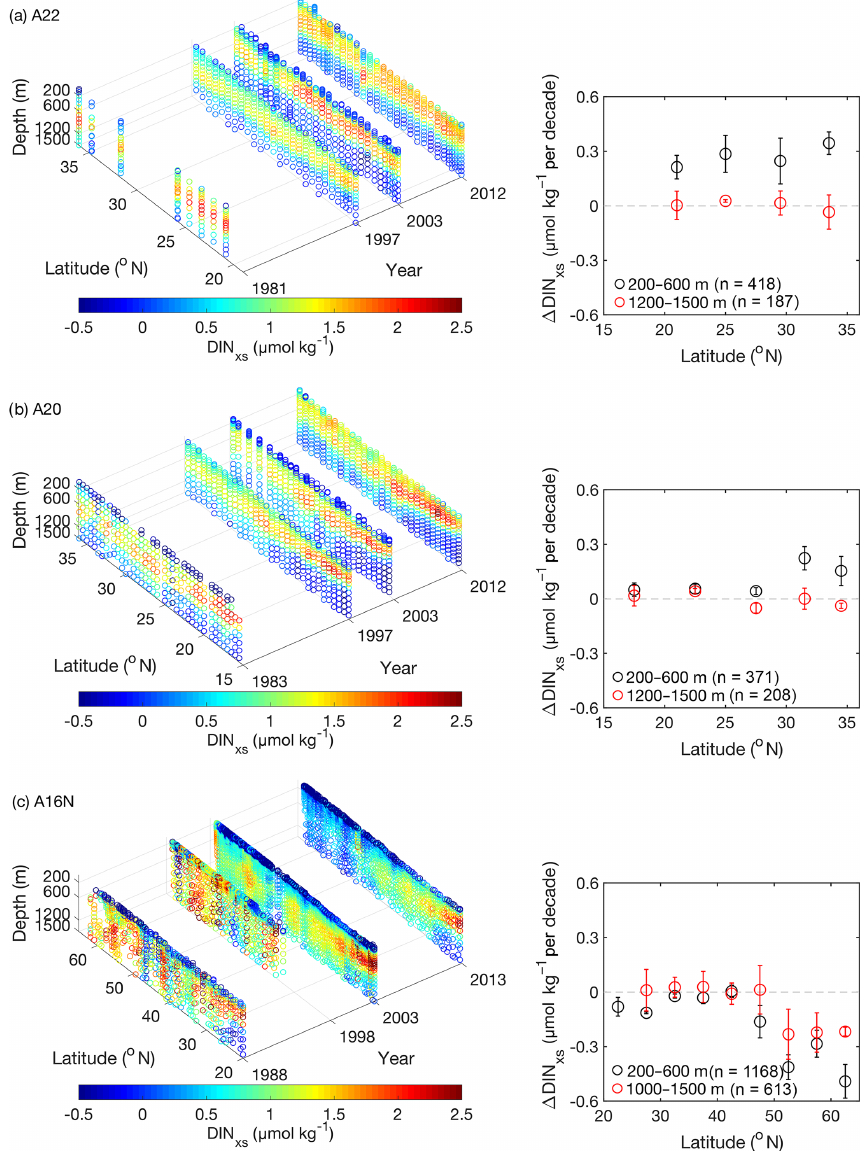
Figure 2. The vertical distributions of DIN xs in the upper 1500m for different cruises along three meridional transects are shown in (a) A22, (b) A20, and (c) A16N, respectively. The insets in (a) – (c) show the average rates (with 95% confidence limits) of (cid:49) DIN xs at 200–600m and 1200–1500m averaged for each 3–8 ◦ latitude interval between GO-SHIP (2010s) and WOCE (late 1980s to 1990s) time periods along each transect (see Table S1). Data from three cruises between the GO-SHIP and WOCE time periods were used to calculate the (cid:49) DIN xs along each transect (numbers in the insets indicate the number of data points for the (cid:49) DIN xs estimates at depth ranges of 200–600 and 1200–1500m,